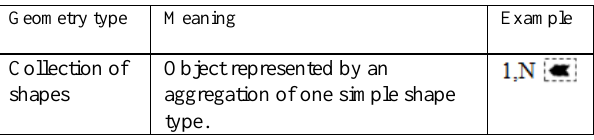
Table 2: Collection of shapes: another type of complex